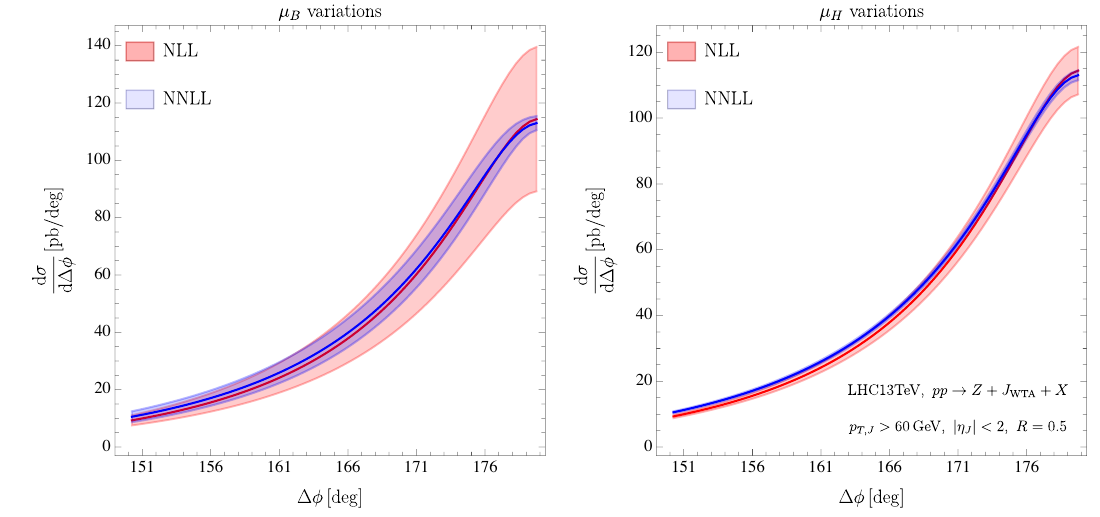
Figure 6. Uncertainties estimated by varying the renormalization scale µ B (left) and µ H (right) up and down by a factor of 2. The rapidity scale variation is not shown, as it is negligible for our central scale choice for µ B